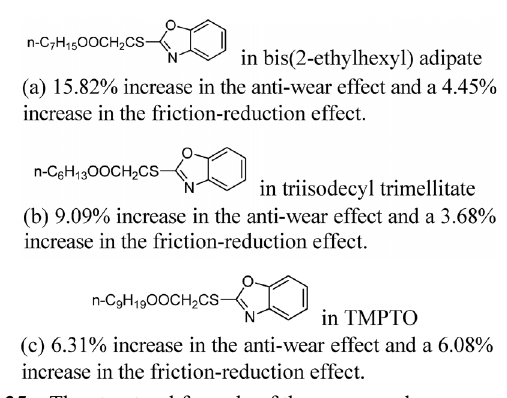
Fig. 35 The structural formula of the